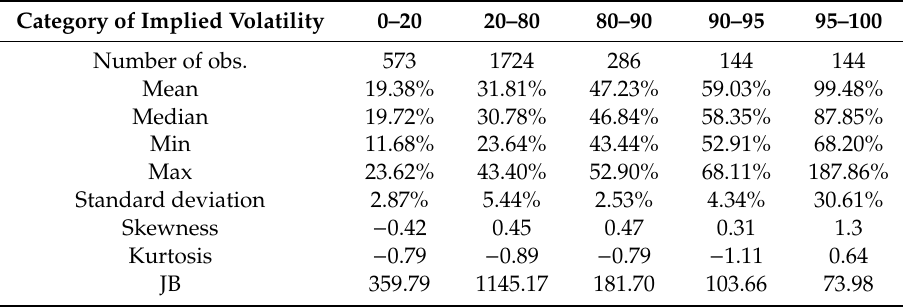
Table 2. Descriptive statistics of implied volatility for ATM